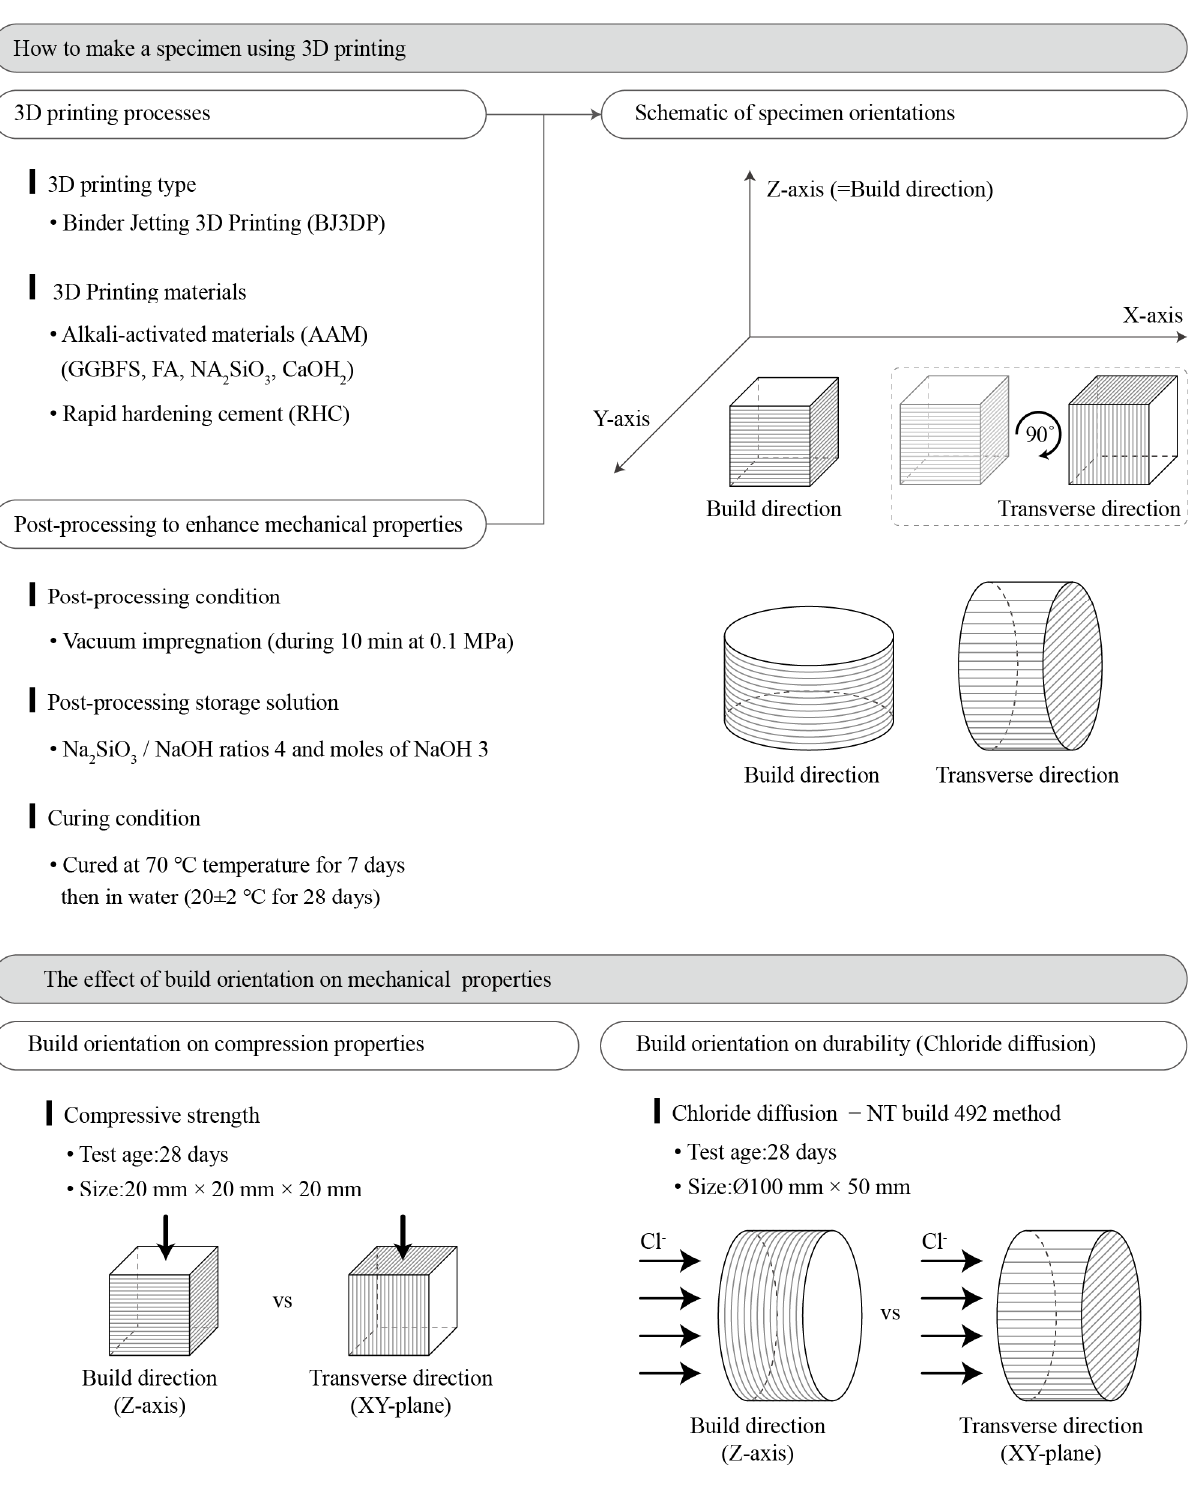
Figure 3. Research plan and purpose.